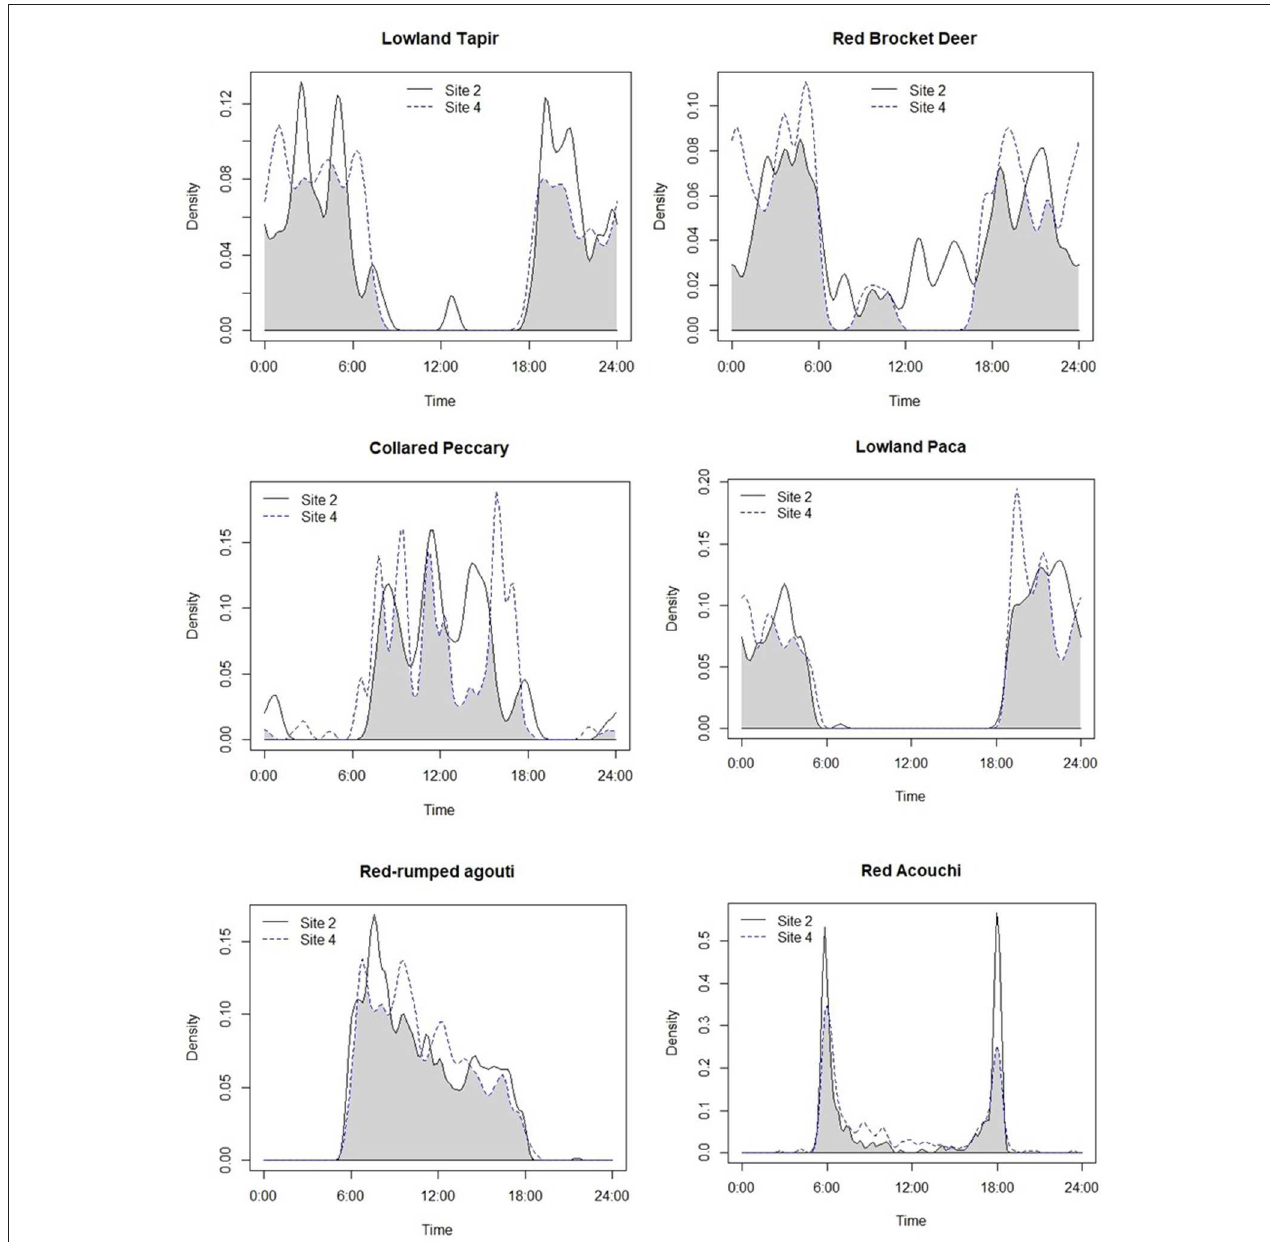
FIGURE 3 | Overlap in the activity patterns of species of interest at Site 2 (very low hunting intensity) and Site 4 (high intensity sites), keeping habitat (tropical forested) and season (rainy)